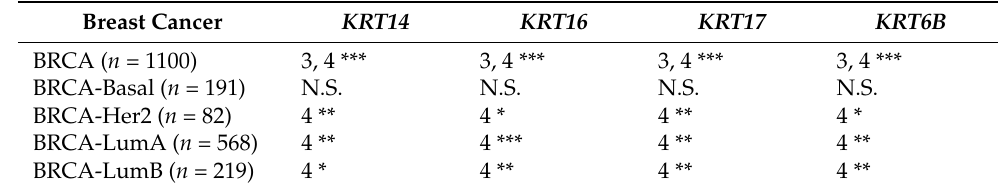
Table 2. Clinical relevance of KRT14 , KRT16 , KRT17, and KRT6B gene expression levels across various cancer types analyzed by the disease stage